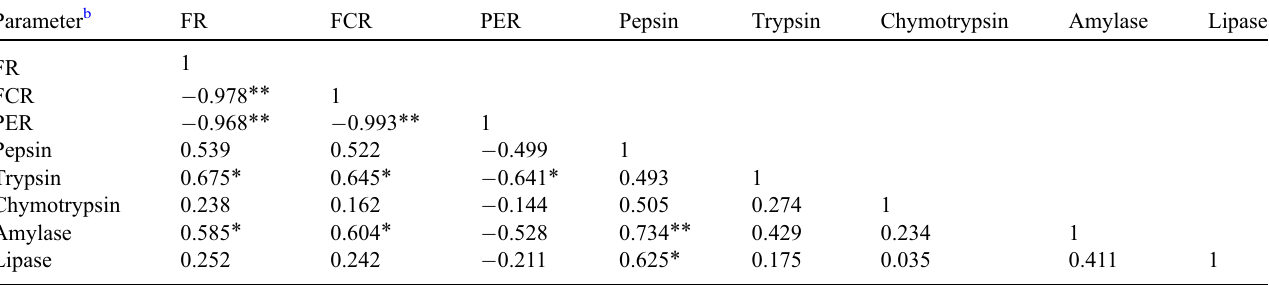
Table 4. Pearson correlation coef fi cients ( r ) a among feed utilization parameters and speci fi c activities of the fecal digestive enzymes. The values were calculated from twelve experimental cases ( n =12).